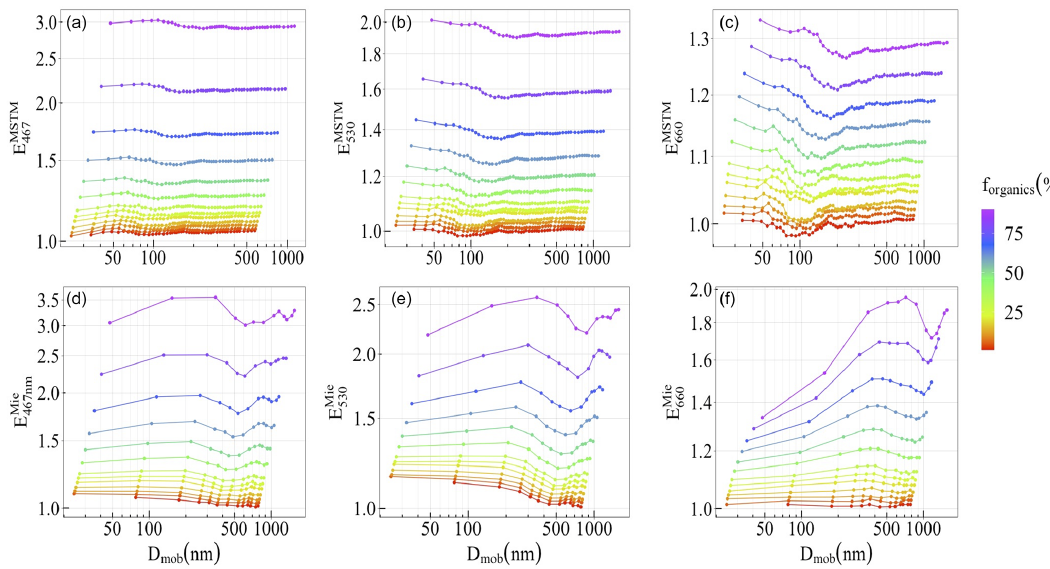
Figure 13. Absorption enhancement factor ( E λ ) in BCFAs with D f = 1.7, changing fraction of organics ( f organics ), and mobility diameter ( D mob ). Panels (a) – (c) show the E λ derived from the MSTM method, whereas the ones derived from Mie code are shown in panels (d) – (f) . The enhancement factors are shown for wavelengths equal to 660, 530, and 467nm (right to left).